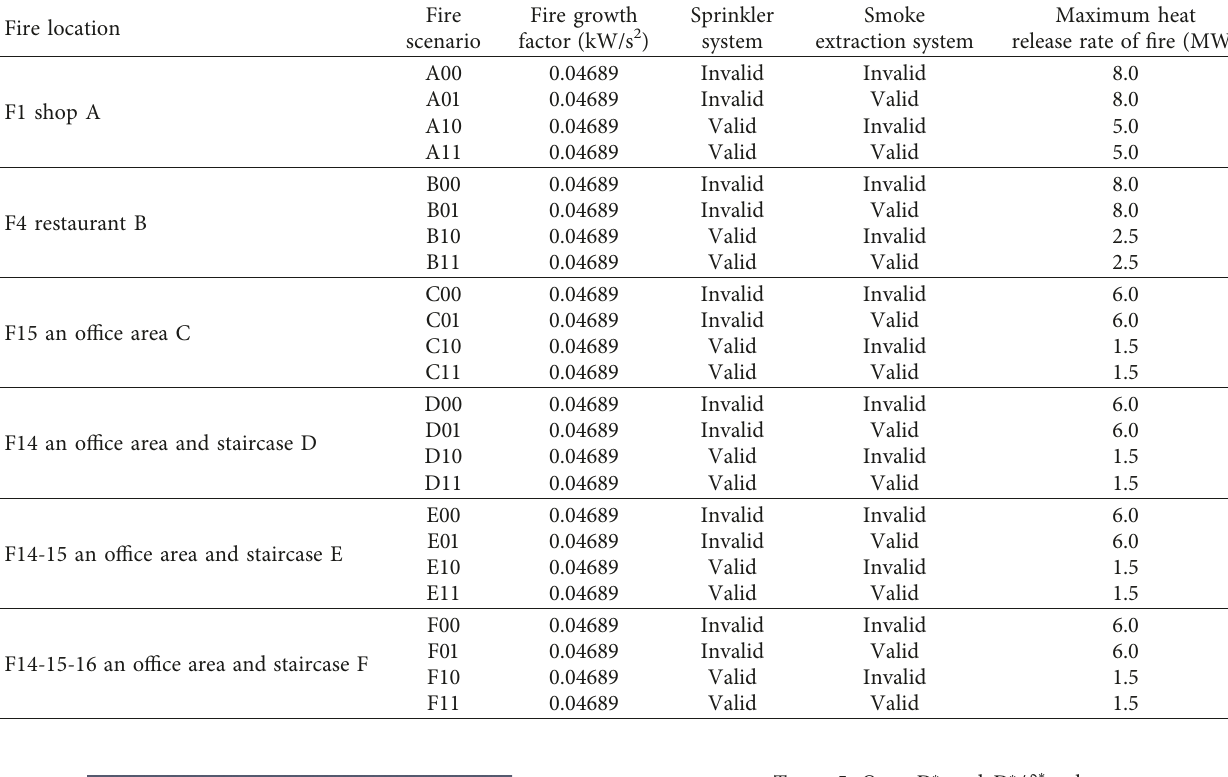
Table 5: Q vs. D ∗ and D ∗ / δ ∗ values.